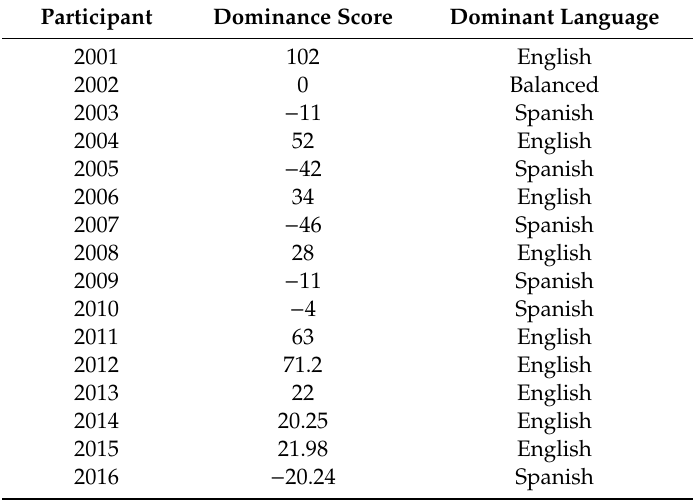
Table A1. Bilingual Language Profile (BLP) individual dominance scores on a scale from − 218 (Spanish) to 218